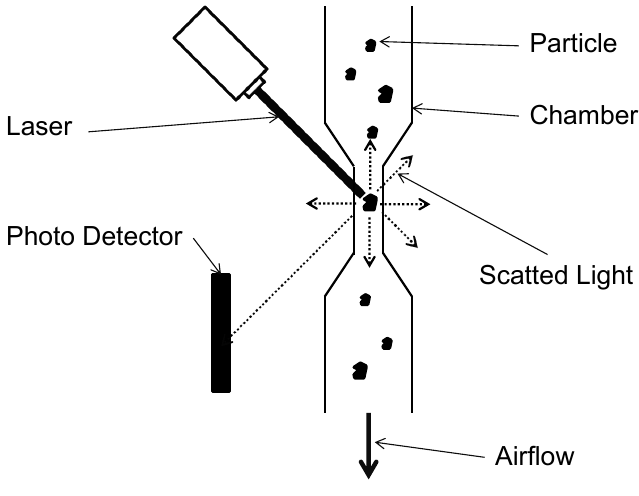
Figure 5. Basic Light Scatting Particle Counter.